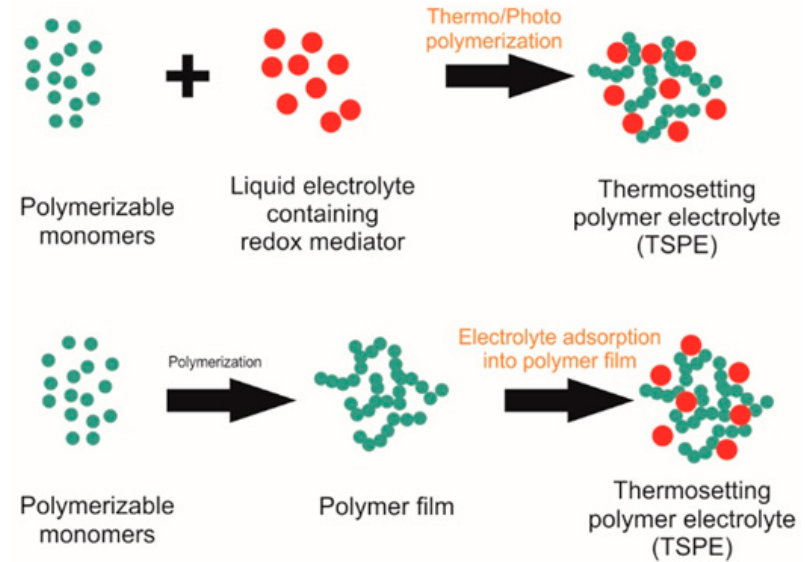
Figure 11. Schematic illustrations of Thermosetting Polymer Electrolytes (TSPE) preparation methods: thermo- and photopolymerization and electrolyte adsorption [248–253].